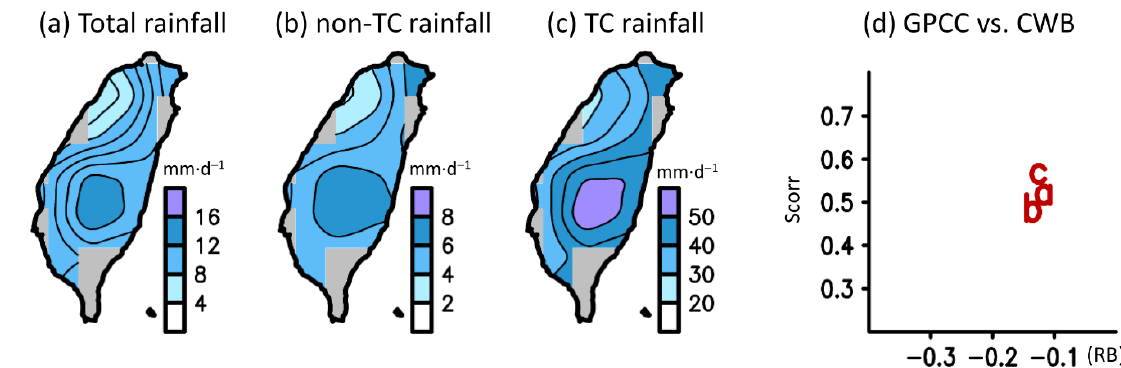
Figure 9. Similar to Figure 2a–c, but for the season mean rainfall of ( a ) total days, ( b ) non-TC days, and ( c ) TC days, estimated from Global Precipitation Climatology Center (GPCC). In ( a , c ), gray shows areas with no data. ( d ) Scorr and RB between GPCC in ( a , c ) and CWB in Figure 2a–c. For comparison with CWB, the GPCC with original spatial resolution of 0.5° × 0.5° is interpolated linearly into 0.1° × 0.1°. Table 6. Scorr values between GPCC for Figure 9a – c and IMERG products in Figure 2a – c. Highest values are bold.